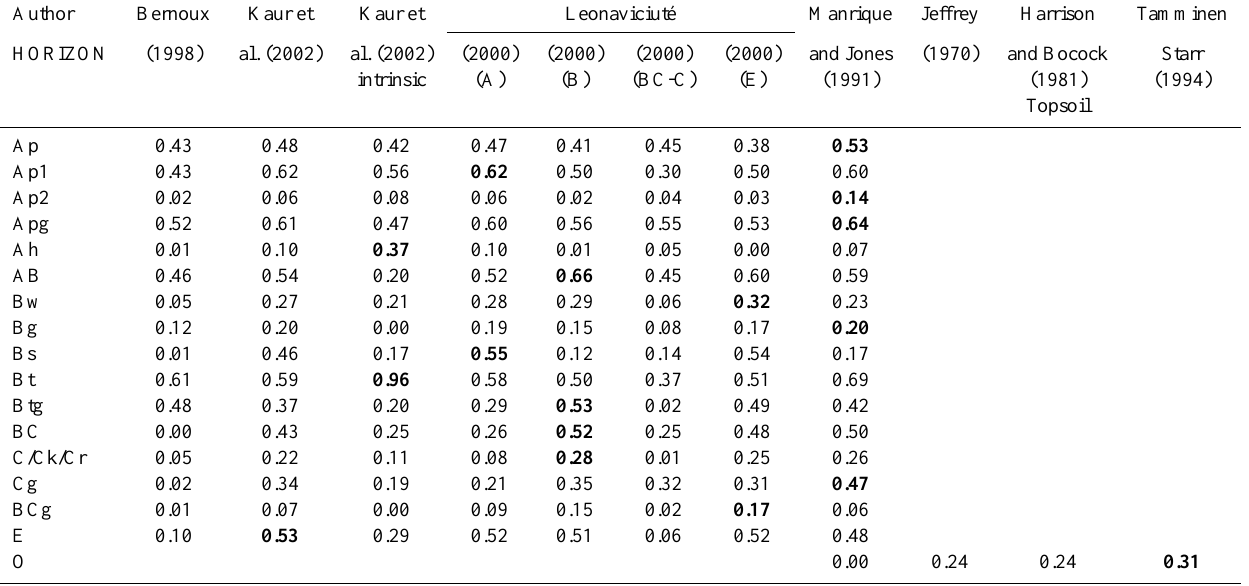
Table 5. Co-efficient of determination values ( R 2 p ) when comparing original bulk density values to predicted values for each horizon type, using complimentary prediction quality indices (De Vos et al., 2005). Bold indicates the highest R 2 p value for a particular horizon